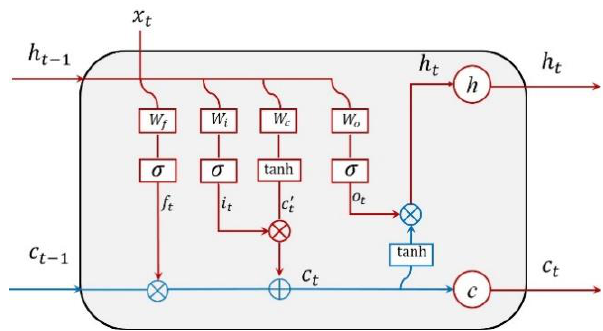
Figure 5. Complete structure of an LSTM memory block with one memory cell.